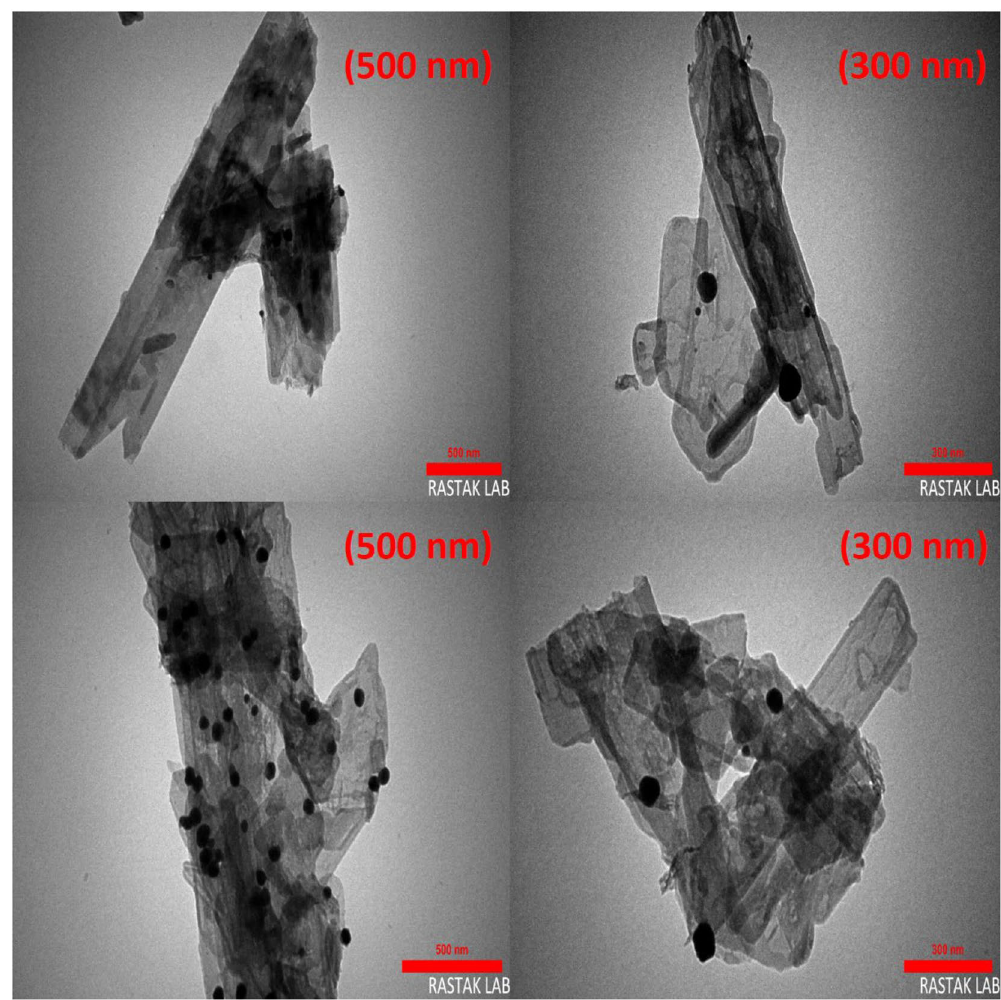
Figure 1. TEM images of